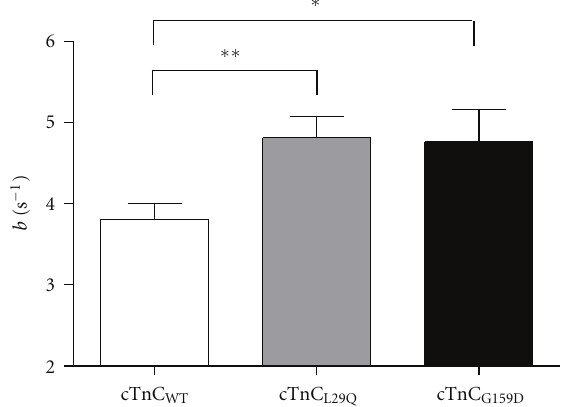
Figure 7: Comparison of XB recruitment dynamic, b , in detergent-skinned fibers reconstituted with cTnC WT , cTnC L29Q , or cTnC G159D . b was estimated by fitting the R-D model to the force responses from muscle fibers to chirp-length perturbations [35]. One-way ANOVA was used to compare estimates of b in cTnC L29Q and cTnC G159D fibers with the data from cTnC WT fibers as controls. Values are expressed as mean ± SEM. Number of fibers tested in each group is as follows: cTnC WT , n = 15; cTnC L29Q , n = 10; cTnC G159D , n = 14. Minimal statistical significance was set at α = 0 . 05. ∗ P < 0 . 05; ∗∗ P < 0 . 01